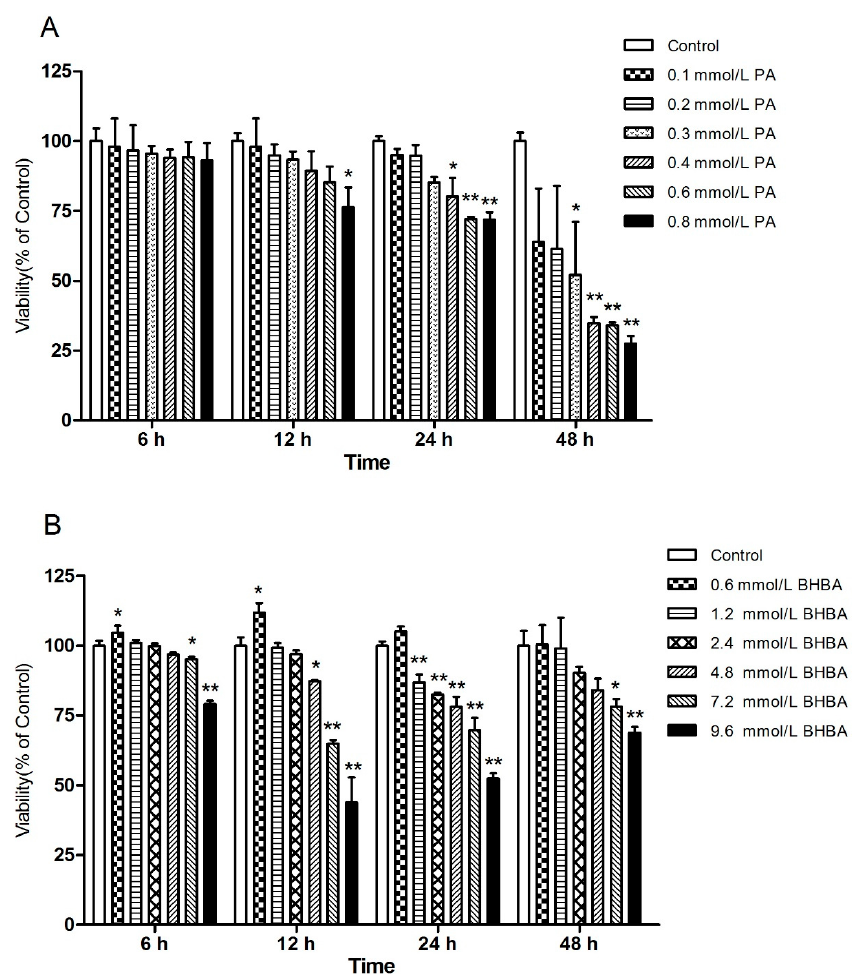
Figure 1. Effects of palmitic acid (PA) and β -hydroxybutyrate (BHBA) on cell viability. ( A ) Bovine endometrial cells (BEND) cells were treated with PA (0.1, 0.2, 0.3, 0.4, 0.6, or 0.8 mmol / L) for 6, 12, 24, or 48 h. ( B ) BEND cells were treated with BHBA (0.6, 1.2, 2.4, 4.8, 7.2, or 9.6 mmol / L) for 6, 12, 24, or 48 h. * P < 0.05, ** P < 0.01 vs. the control.